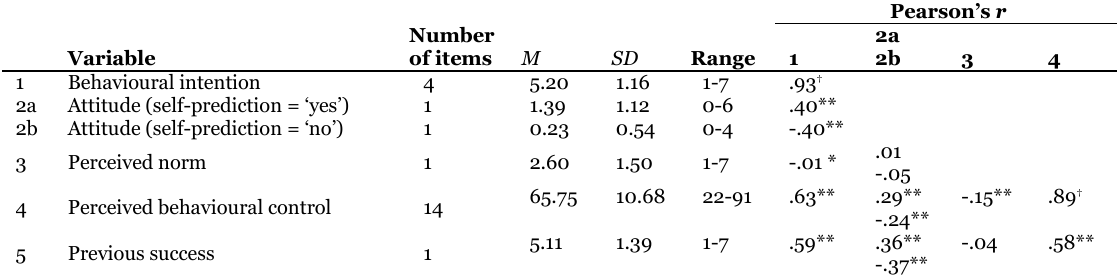
Descriptive Data of the Used Variables (N =